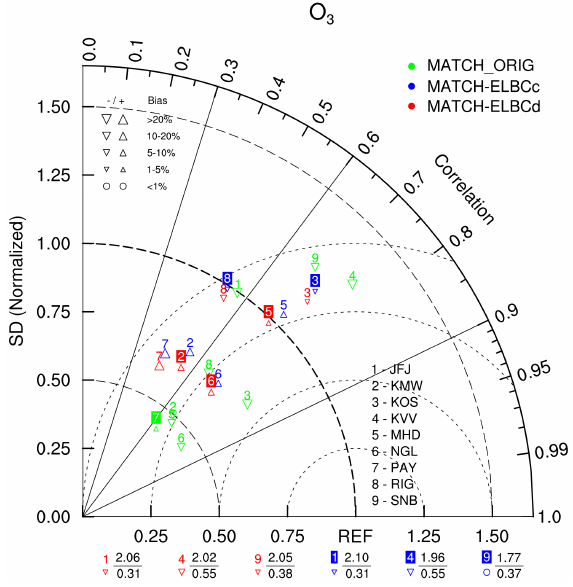
Figure 9. Same as Fig. 8, but for O 3